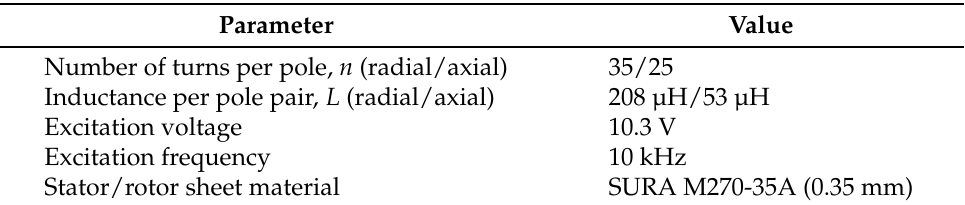
Figure 5. Cross-section of the sensor at poles corresponding to axial measurements. Numbers denote the following parts: 1—axial sensor stator stack, 2—radial sensor stator stack, 4—non-magnetic aluminium holding parts, 3—laminated rotor part. Table 2. Design